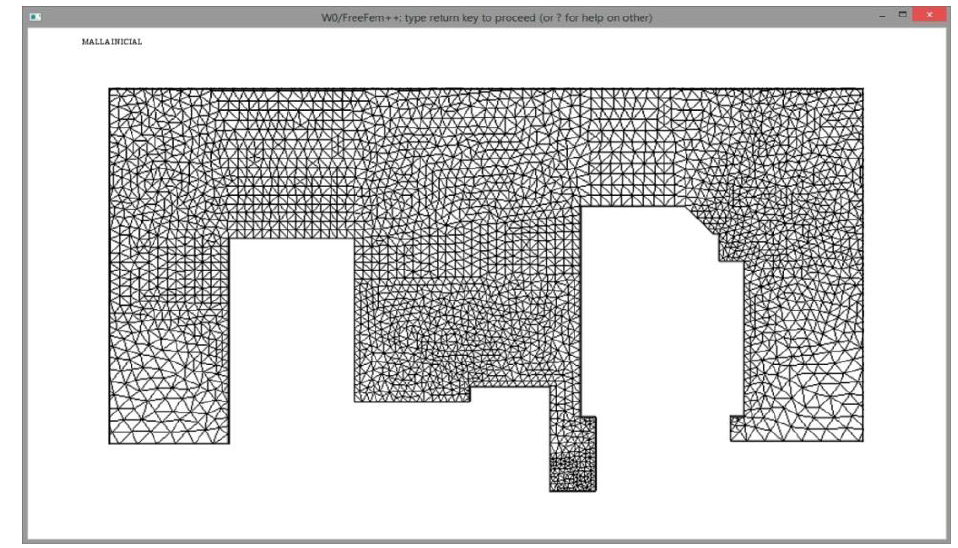
Figure 1. 2D example of building geometry.